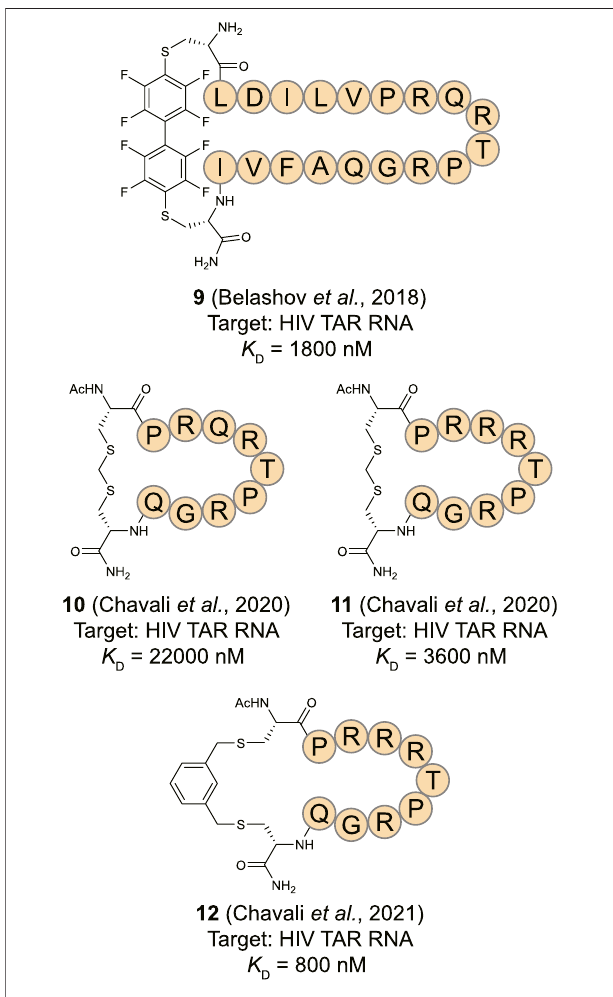
FIGURE 6 | Structures of HIV TAR RNA binding cyclic peptides derived from RNA-recognition motif